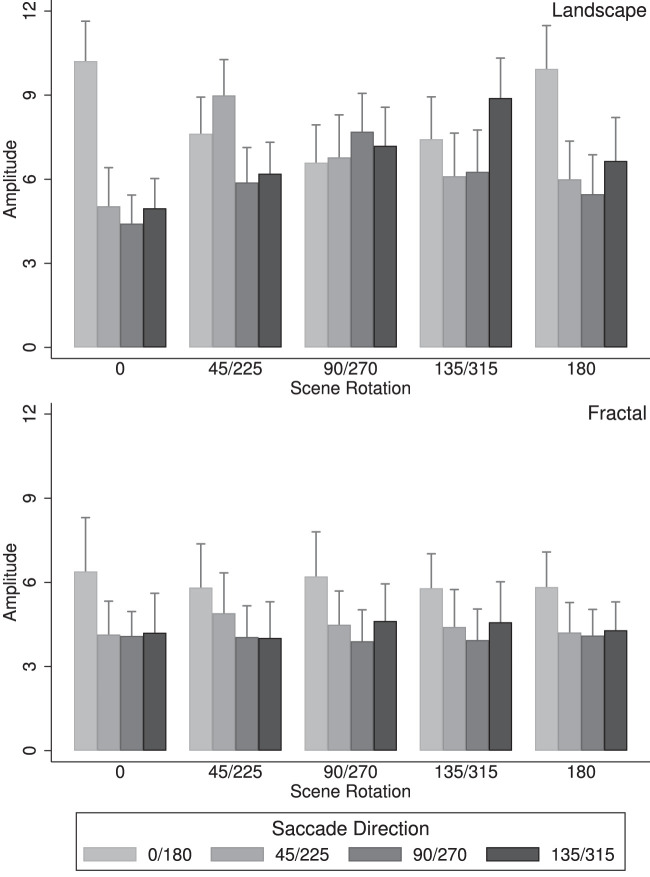
Amplitudes of head shifts along four axes in world coordinates, for landscape scenes (top) and fractal scenes (bottom). Data show the mean amplitudes of head shifts and standard error bars along the four head shift axes (0°/180°, 45°/225°, 90°/270°, and 135°/315°) and the five scene rotation groups (0°, 45°/225°, 90°/270°, 135°/315°, and 180°).